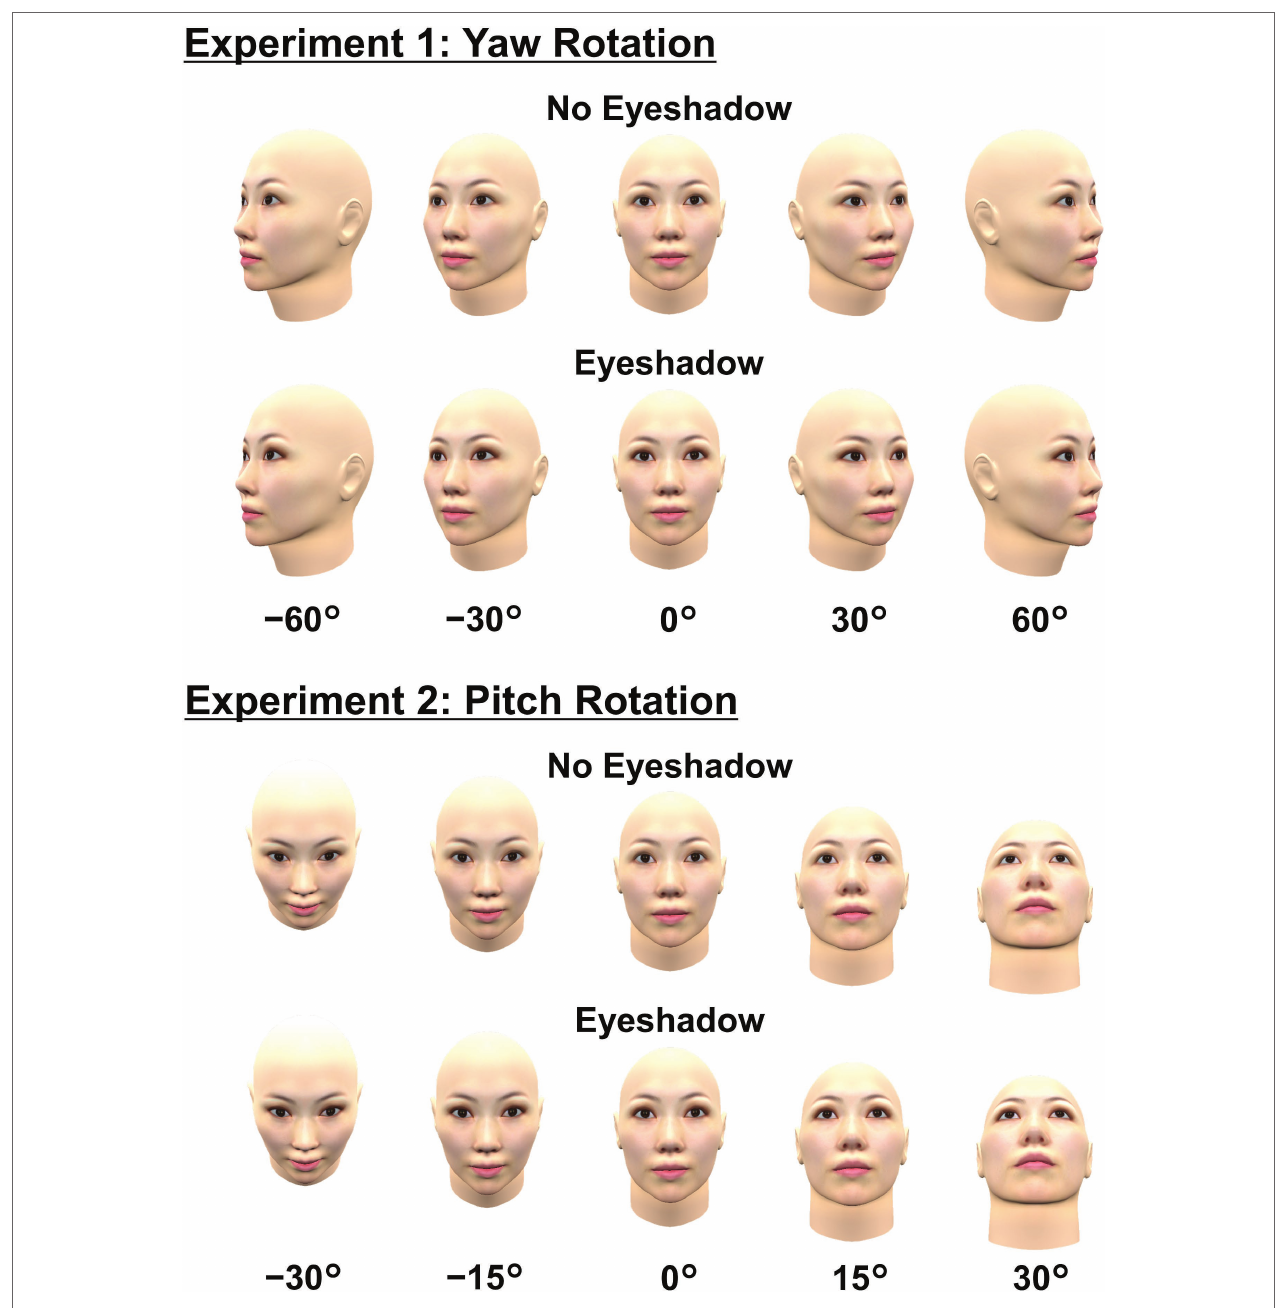
FIGURE 1 | All standard stimuli used in the present